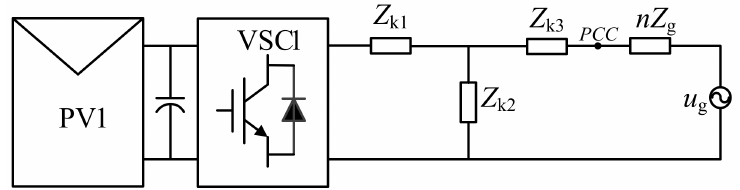
Figure 5. Equivalent schematic diagram of a single